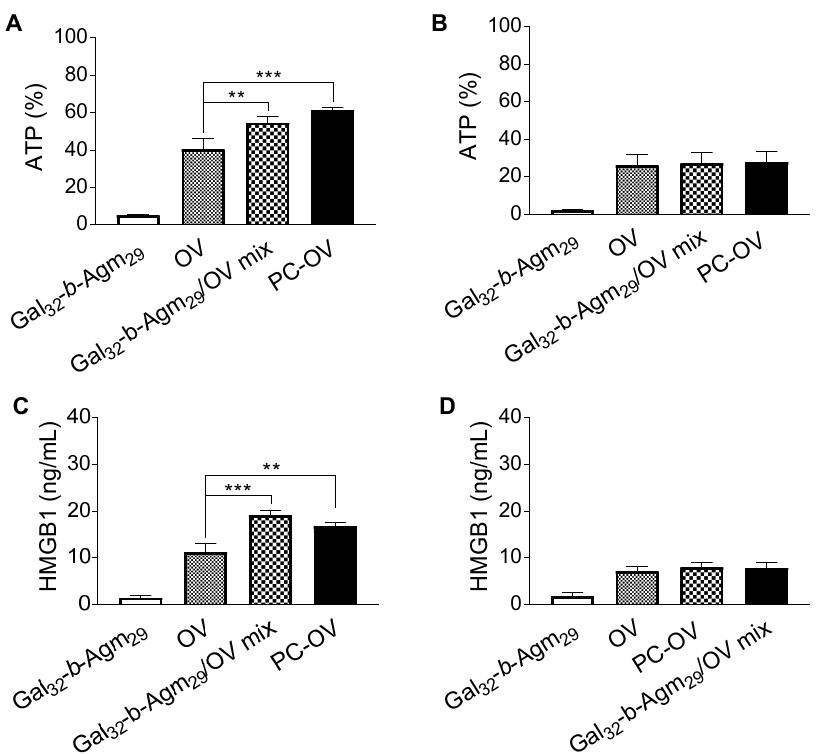
Figure 5. In vitro immunogenic tumor cell death. Extracellular ATP ( A , B ) in the supernatant of HepG2 ( A ) and A549 ( B ) cells after 48 h of treatment. Extracellular HMGB1 ( C , D ) in the supernatant of HepG2 ( C ) and A549 ( D ) cells after 72 h of treatment. Error bars, mean ± SEM: ** p < 0.01, *** p < 0.001.